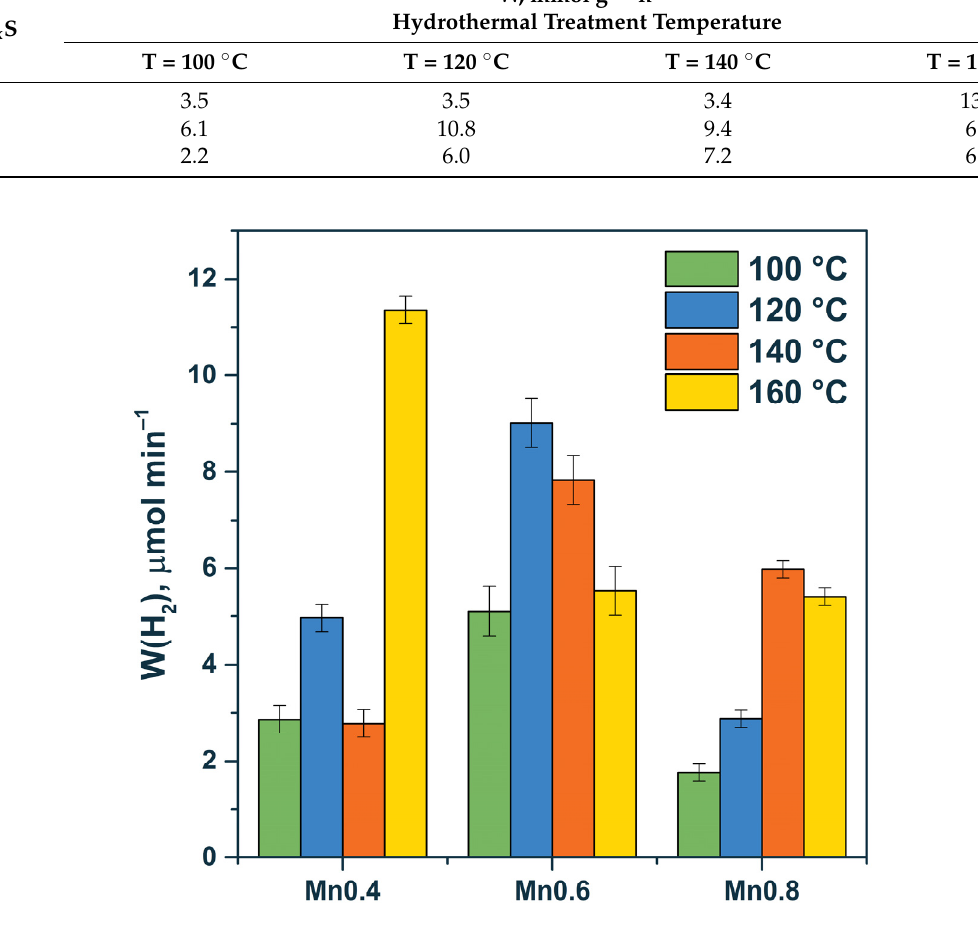
Figure 6. Dependence of the rate of photocatalytic hydrogen evolution on the manganese content for HT100-HT160 series. Experimental conditions: C 0 (Na 2 S/Na 2 SO 3 ) = 0.1/0.1 M, m cat = 50 mg, V susp = 100 mL, and λ = 425 nm.